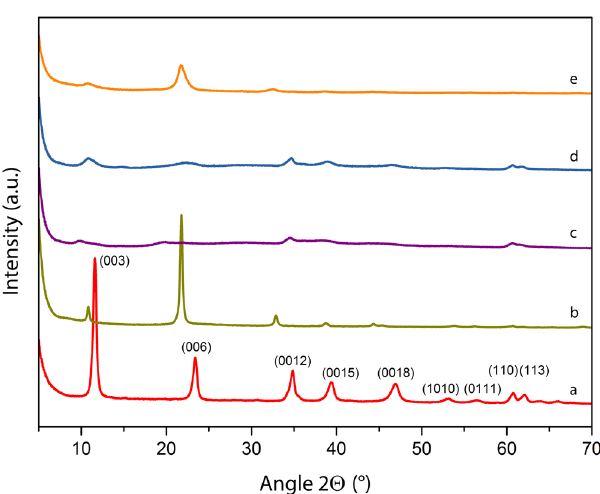
Figure 2. XRD patterns for all LDHs. ( a ) LDH-CO 3 precursor synthesized by hydrothermal microwave- assisted coprecipitation; ( b ) LDH-I sample prepared from intercalation of iodide ions (I − ) in between the layers of the LDH-CO 3 host. The effect of turbostraticity is visible in the peak inversion ( c ) LDH-H 2 O 2 -MW sample synthesized by microwave radiation (route A 1 ) of LDH-H 2 O 2 suspension; ( d ) LDH-H 2 O 2 -I sample prepared by addition of 1 mM KI solution to LDH-H 2 O 2 suspension (route A 2 ) and ( e ) LDH-I-H 2 O 2 sample prepared by immersion of LDH-I in H 2 O 2 solution (route